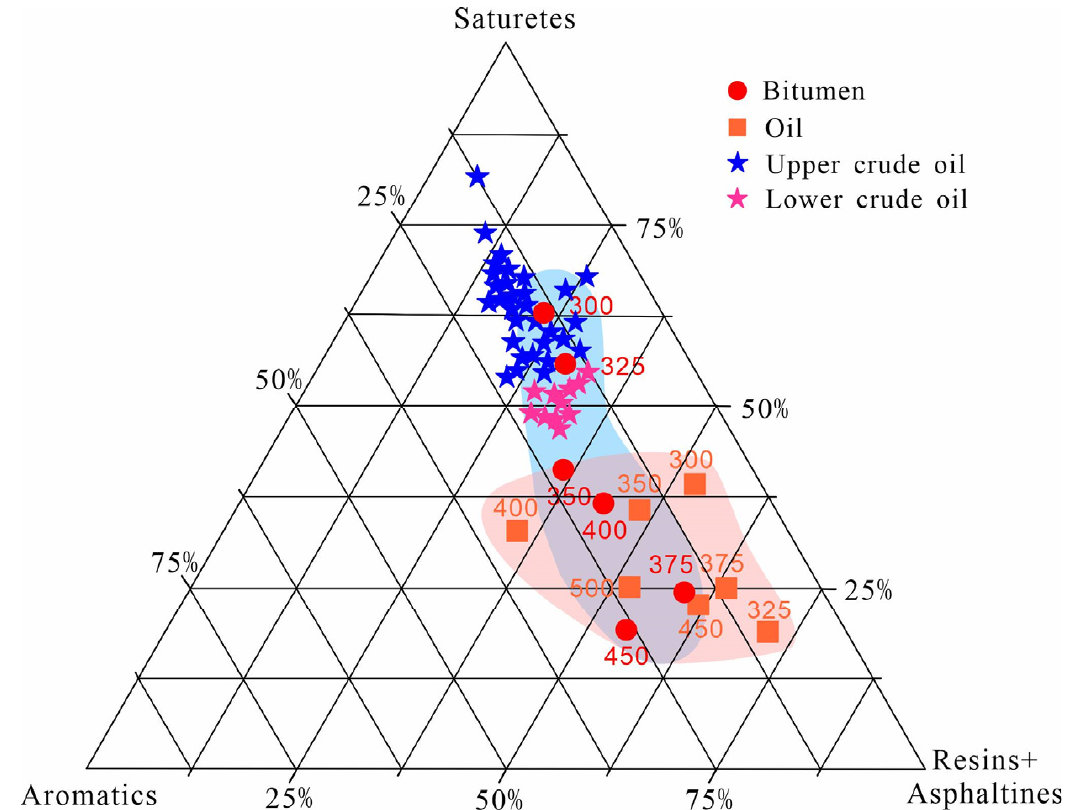
Figure 11. Ternary diagram of the SARA fractions of oil and bitumen, and comparison with natural crude oil from lacustrine sources. The crude oil data are from Cao et al. [43].